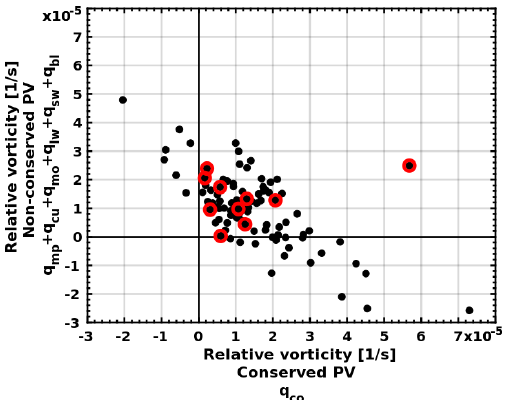
Figure 10. Scatterplot relating the balanced relative vorticity fields after inverting the conserved PV tracers ( x axis) to the sum of all non-conserved PV tracers ( y axis). Red circles depict the 10 medi- cane cases in our